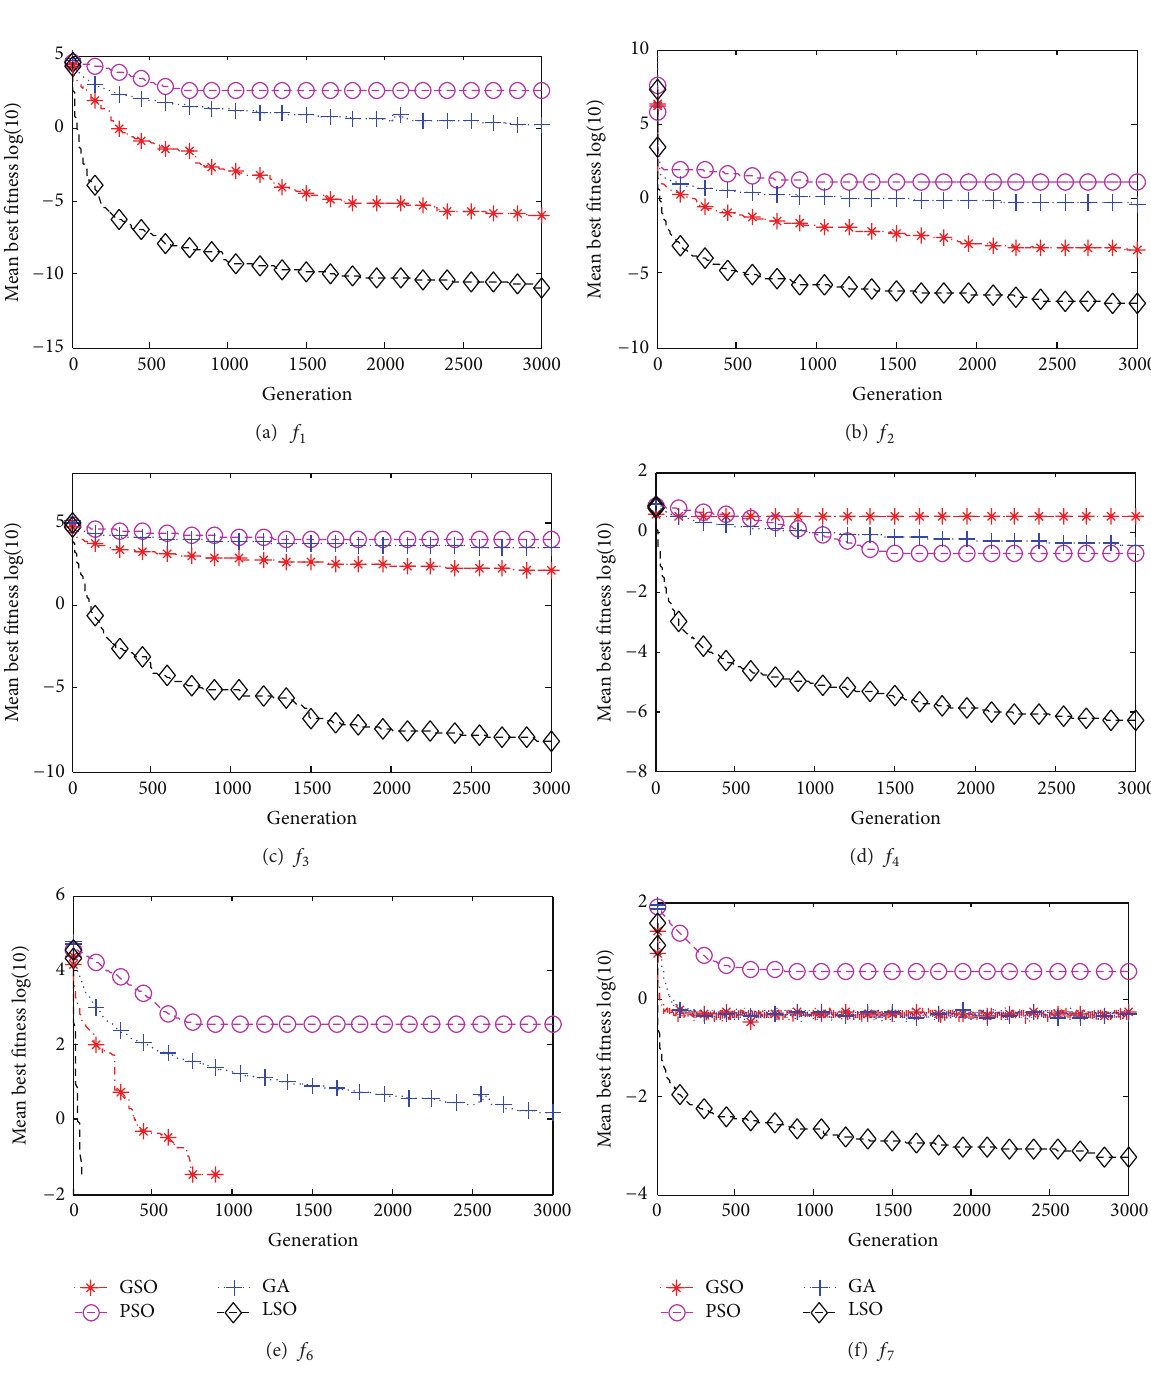
Figure 4: Convergence results of unimodal functions 𝑓 1 , 𝑓 2 , 𝑓 3 , 𝑓 4 , 𝑓 6 , and 𝑓 7